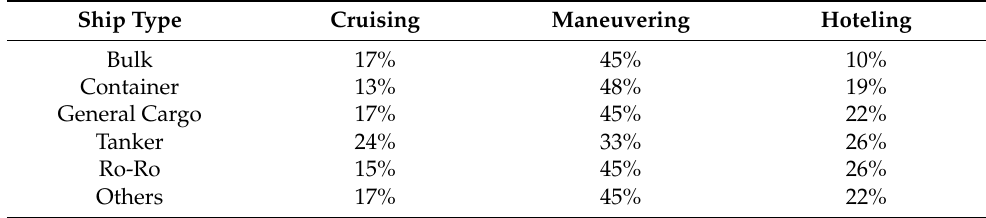
Table 6. Load factor of an auxiliary engine.